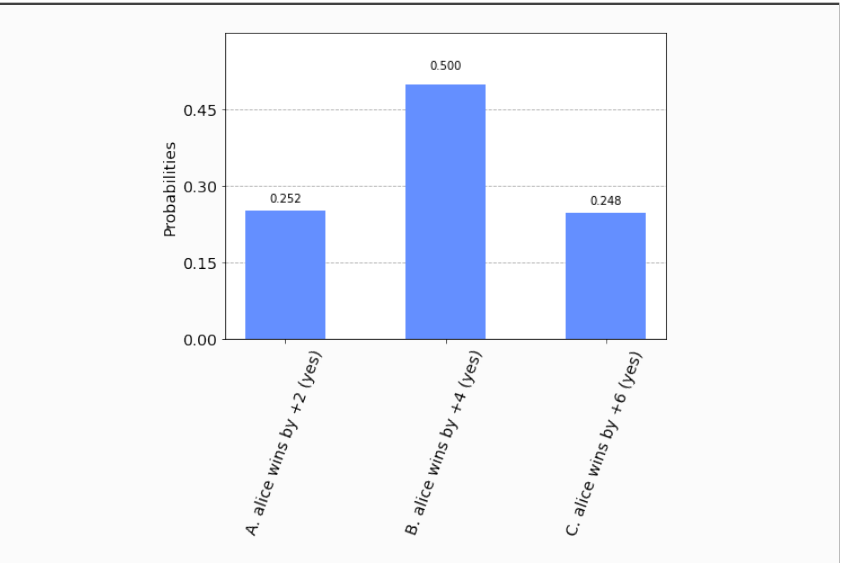
Figure 17. The possible outcomes and their probabilities with 2 independent legislators and r A = r B = 0.